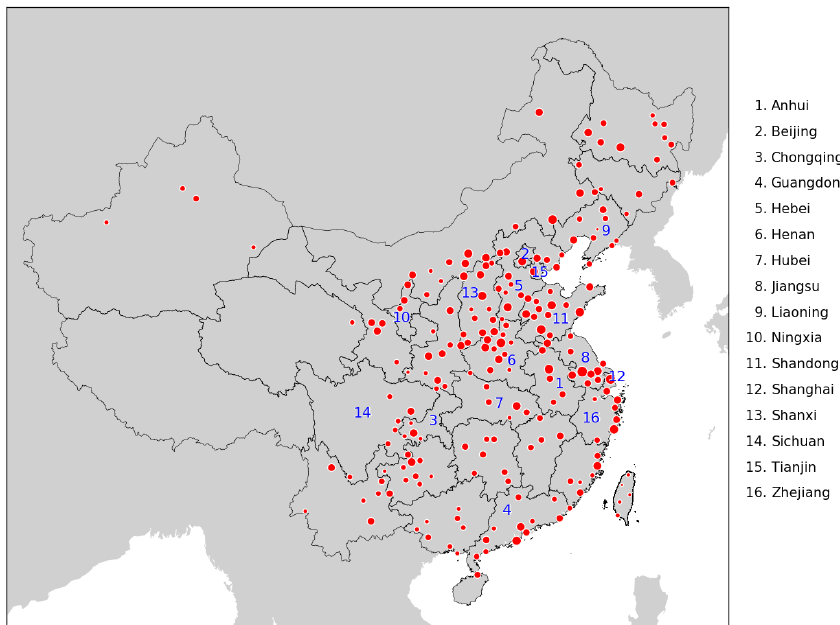
Figure 1. Location of power plants in China according to REAS v.2 (Kurokawa et al., 2013). The size of each dot indicates the emission of the power plants (power plants in close proximity are combined in a single dot). In addition, a list is given of the provinces mentioned in this